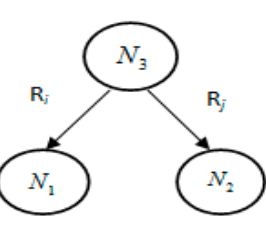
Figure 4. UNL graph of two nodes with the common parent.